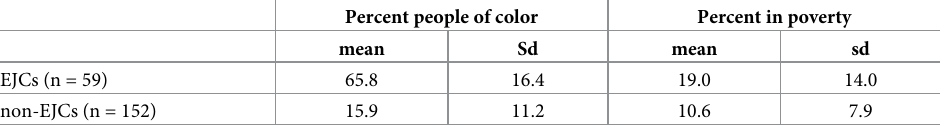
Table 1. Basic statistics of k-means cluster analysis of census tracts hosting EGUs in RGGI.